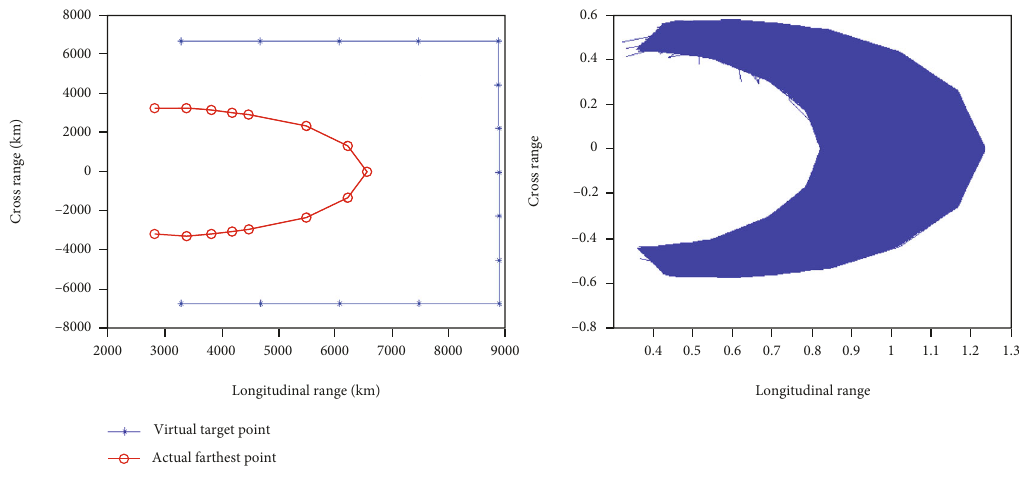
Figure 3: The reachable area under nominal conditions. Table 3: List of fi tting results of di ff erent forms of curves. Order Curve